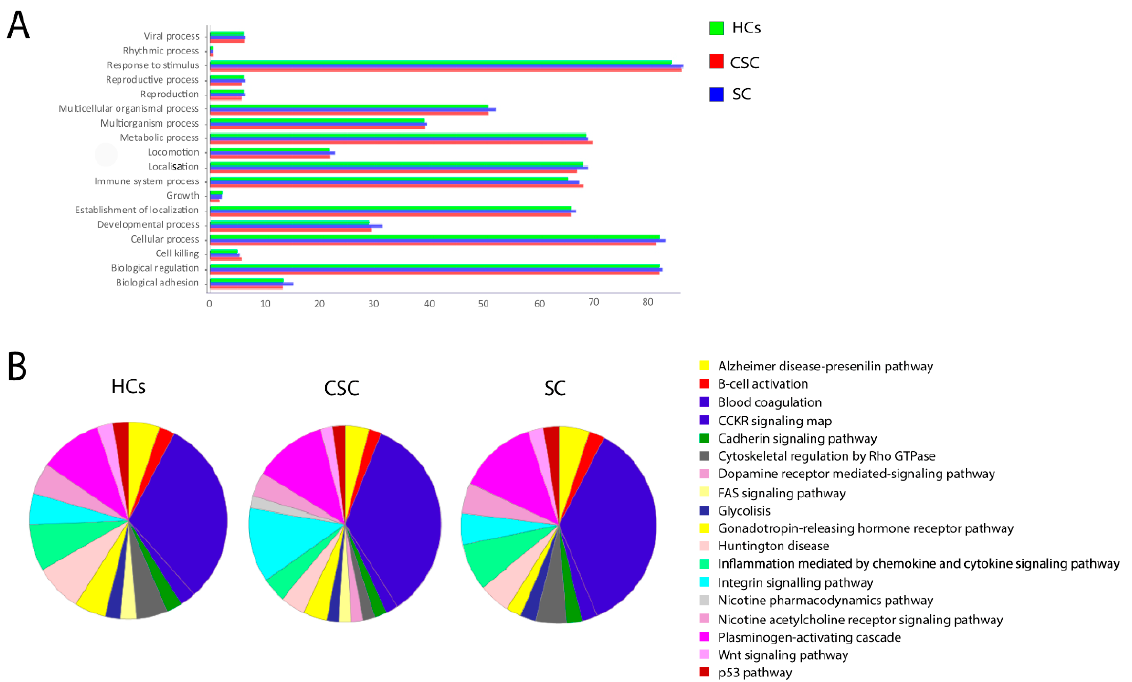
Figure 3. Gene ontology functional classification of serum-derived EV proteomes: ( A ) biological process; ( B ) pathways. Abbreviations: CSC, cortical-subcortical stroke; HCs, healthy controls; SC, subcortical stroke.